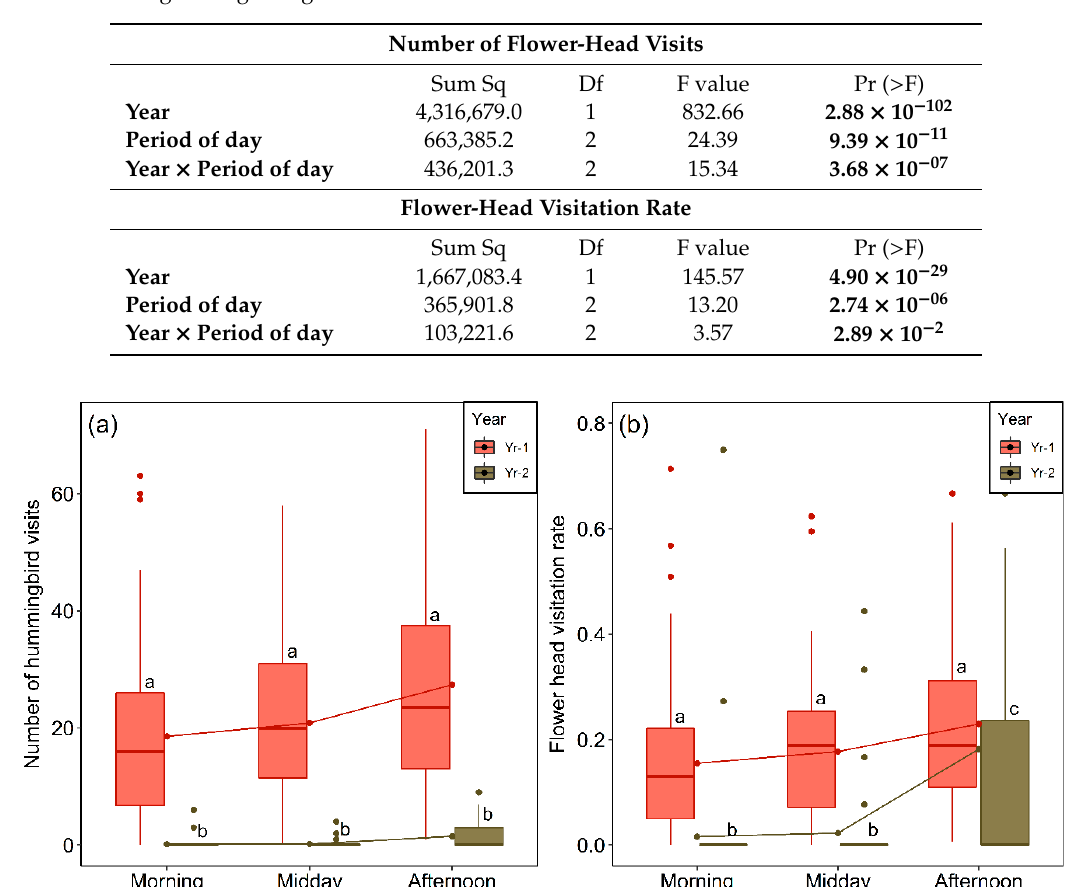
Figure 7. ( a ) Comparison of number of visits to flower-heads of M. subulata in equal-sized sampling areas (visitation frequency) over different periods of the day for the last two years of the Chilean mega drought. The raw data are the number of visits per hour per plot on each day of pollinator sampling (Yr-1, N = 240; Yr-2, N = 192). ( b ) Flower-head visitation rates per hour per plot in M. subulata over different periods of the day for same two years. Outliers (values higher than 1.5 times the interquartile range above the upper quartile) are shown as dots. Lower case letters indicate significant differences between years ( p < 0.05) according to Dunn’s test.